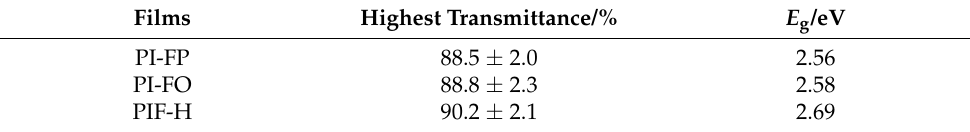
Figure 6. The relation between absorption coeffi- cient spectra and the energy gap. Table 3. The cut-off wavelength and highest transmittance of PI films.